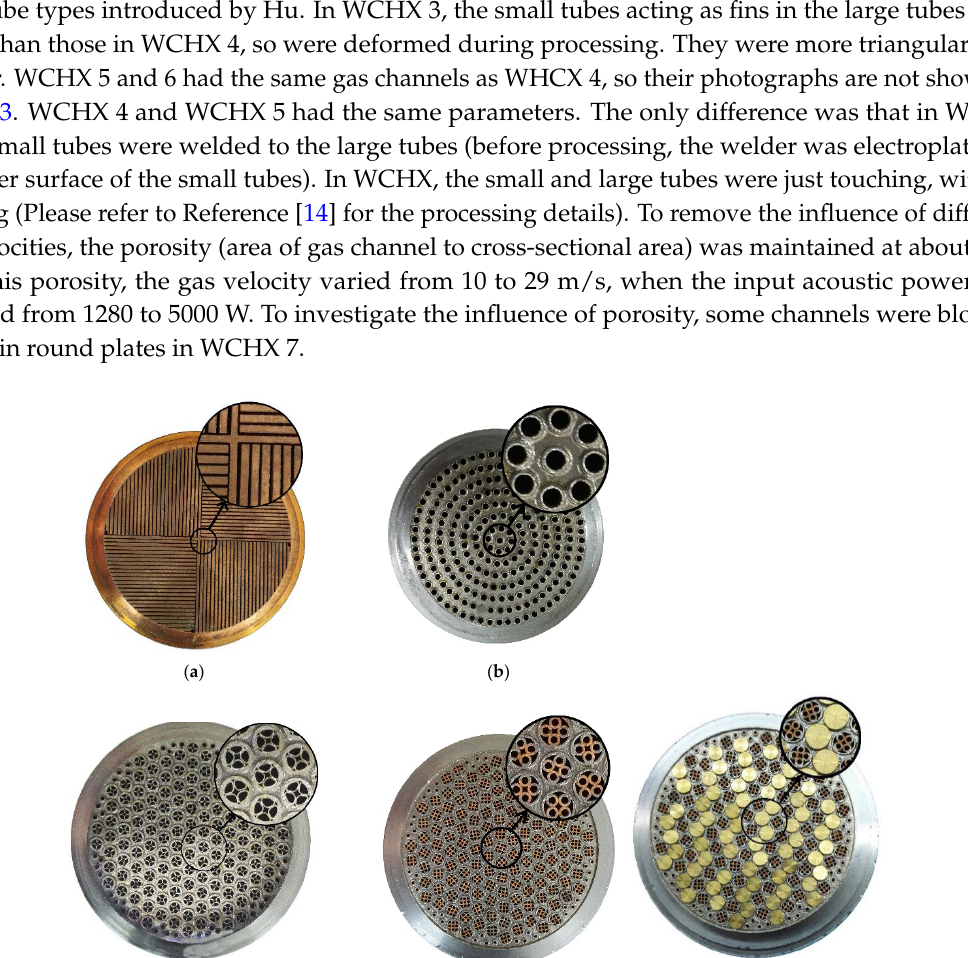
Table 1. Operating conditions and component size.